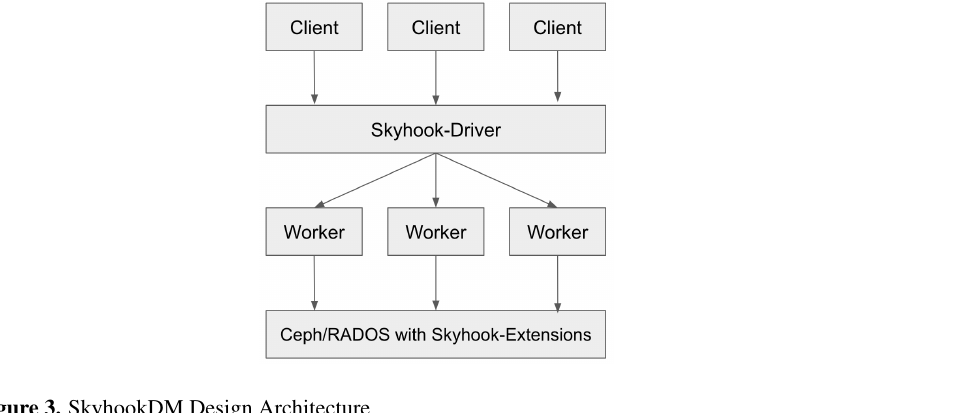
Figure 3. SkyhookDM Design Architecture